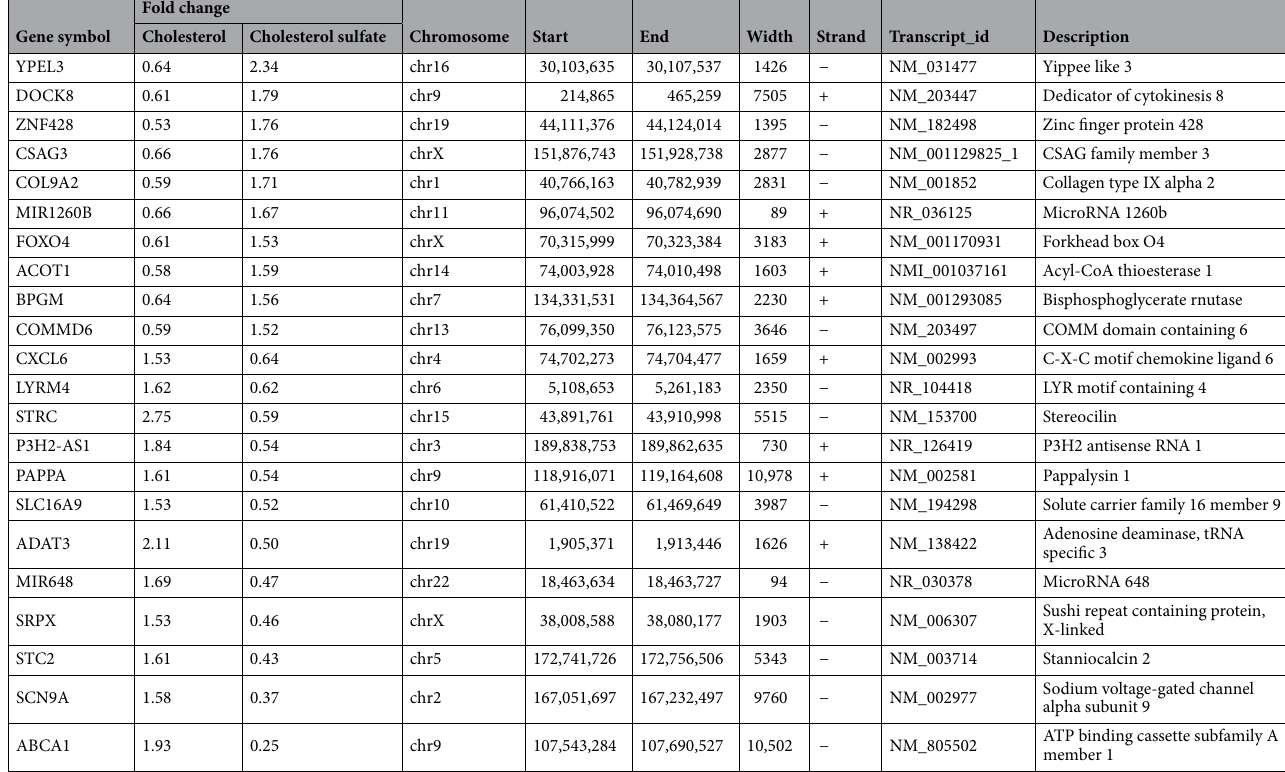
Table 1. HaCat cells were treated with cholesterol (20 μg/mL) or cholesterol sulfate (20 μg/mL) for 24 h. RNA sequencing was performed using a HiSeq X10. Cut off ≥ 1.5-fold ( p <